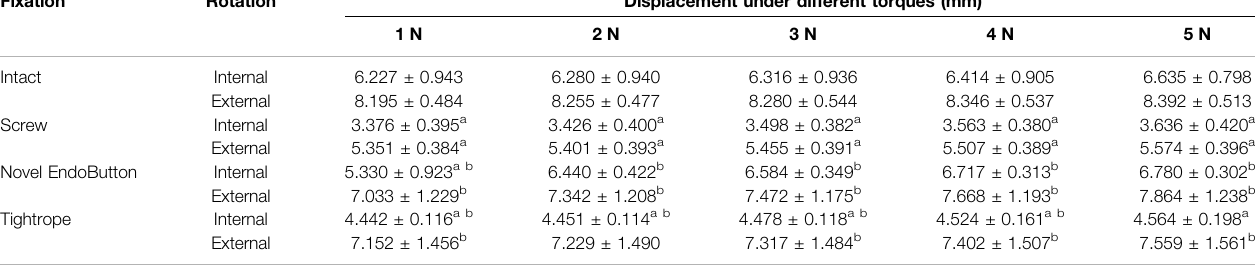
TABLE 2 | Displacement in internal and external rotation. Fixation